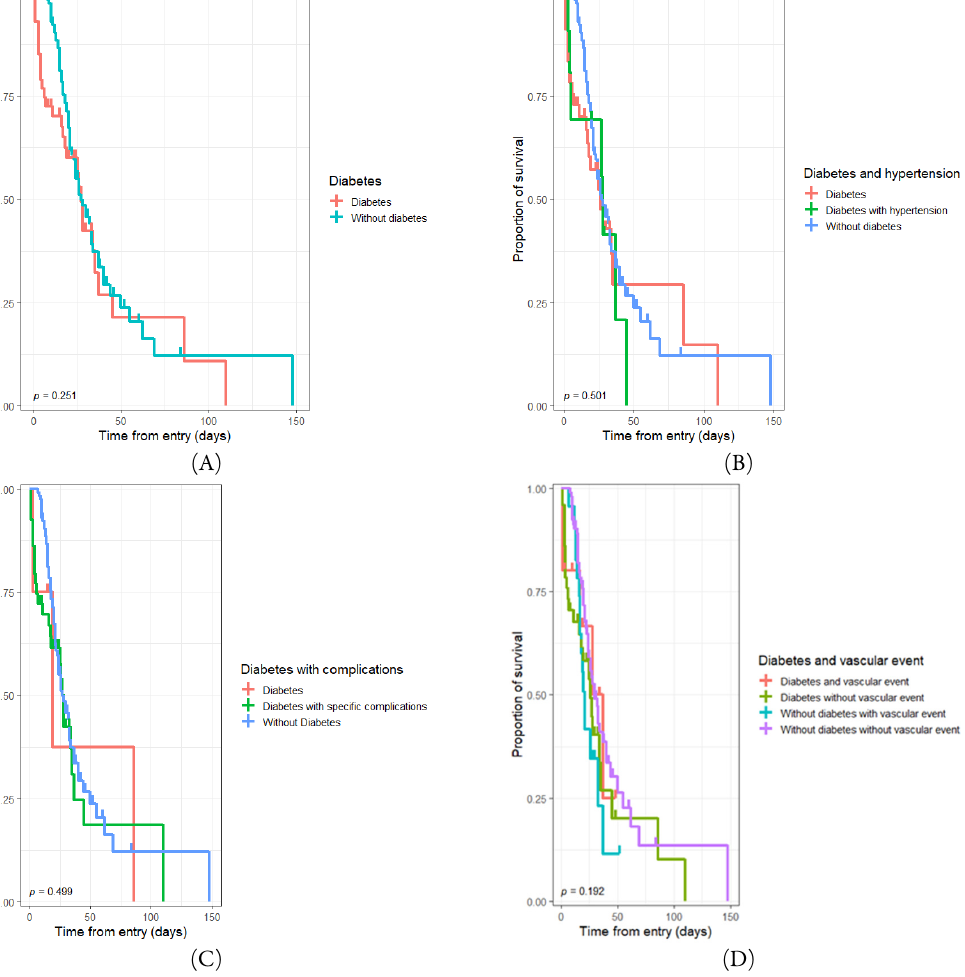
Figure 1. Survival during hospitalization period regarding the presence of diabetes (A), hypertension (B), diabetic complications (C) and vascular events